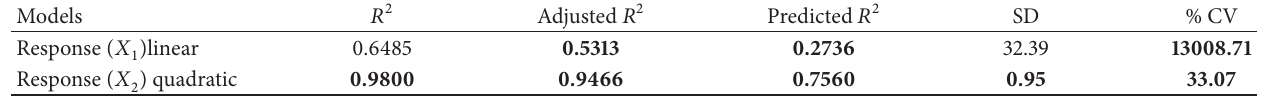
Table 2: Summary of results of regression analysis for responses 𝑋 1 and 𝑋 2 .